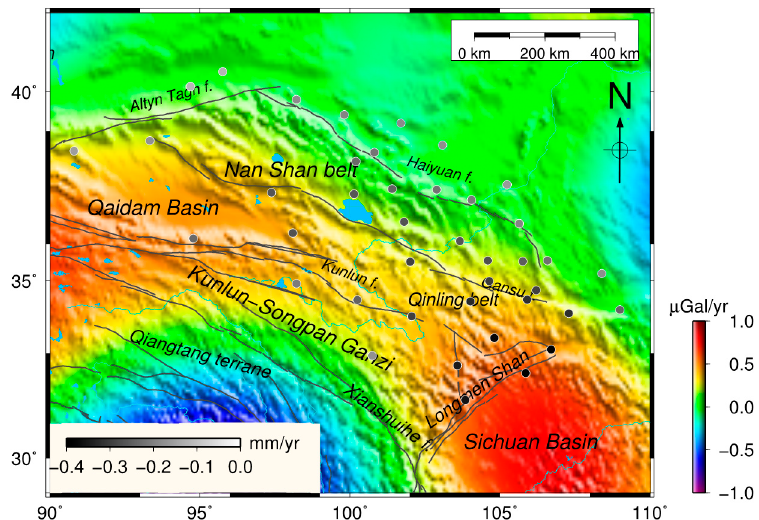
Figure 6. GRACE mass change in Tibet. The CSR RL5 was used to estimate the gravity in northeastern Tibet, spanning from April 2002 to November 2014. The dots denote the vertical deformations caused by surface loads corresponding to the GPS sites. The color bars internal and external denote the rates of the GRACE derived loading and gravity variations, respectively.